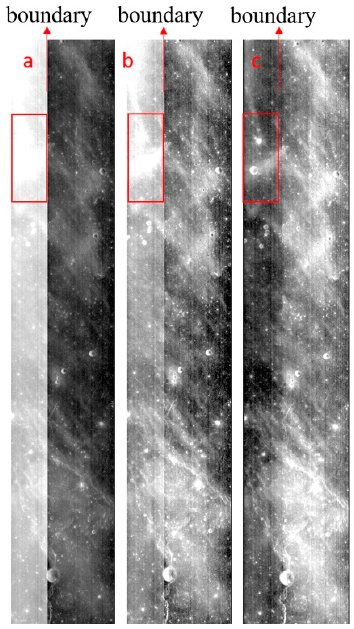
Figure 7. Reflectance data of orbit 2576 with phase range 0~15 ◦ before ( a ) and after ( b ) photometric correction by Hapke model.